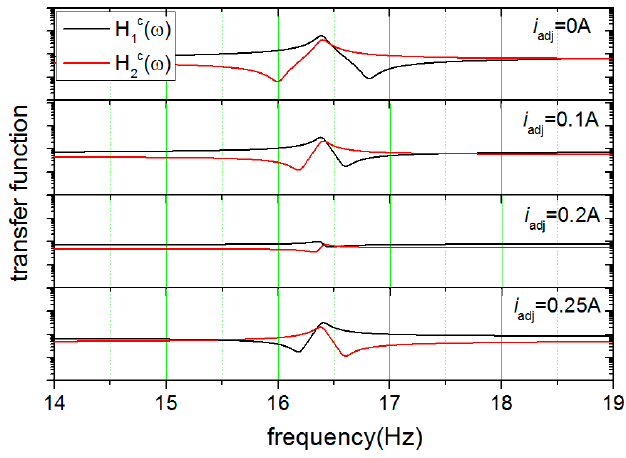
Figure 7. The measured displacement response functions under different adjusting